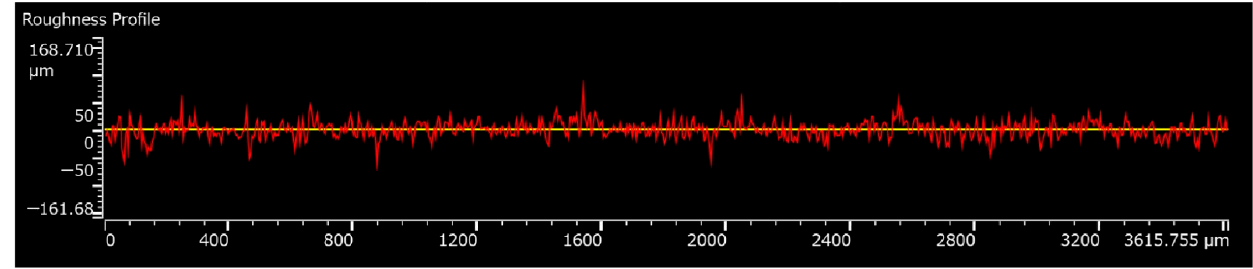
Figure 4. The roughness profile of a raw MC 901